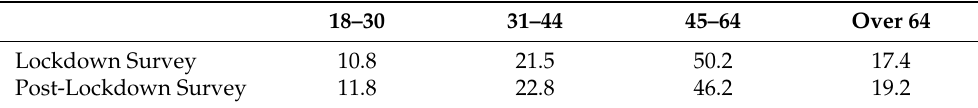
Table 1. Age distributions (in percentages) in the GIPEyOP surveys